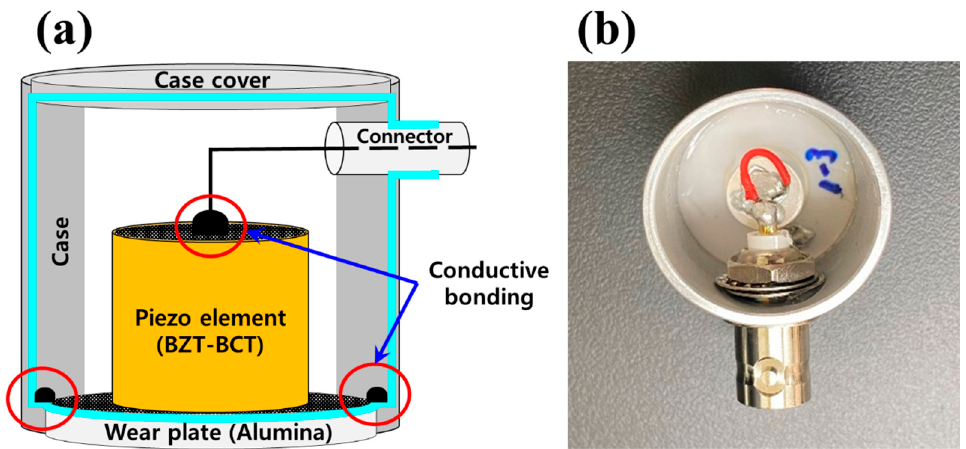
Figure 8. ( a ) Schematic diagram and ( b ) image of the AE sensor.